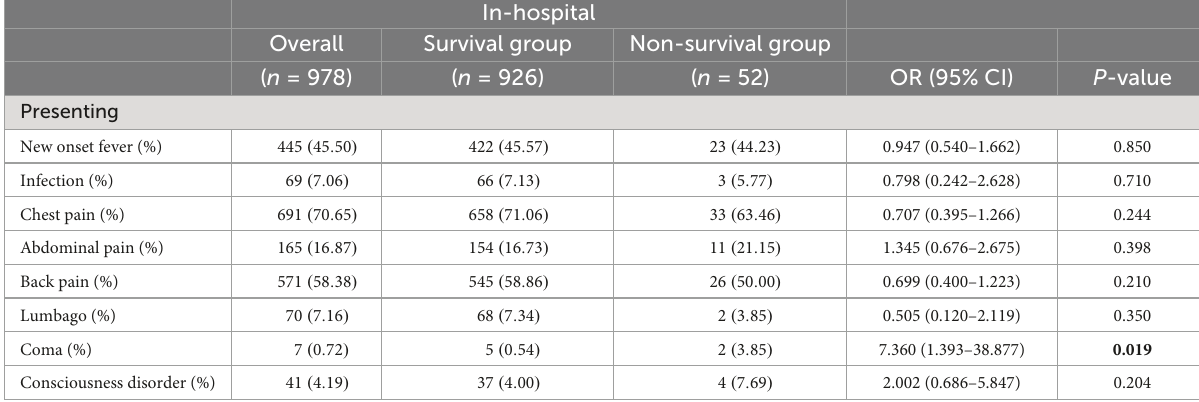
TABLE 2 Presenting symptoms of all patients with Stanford type B aortic dissection.